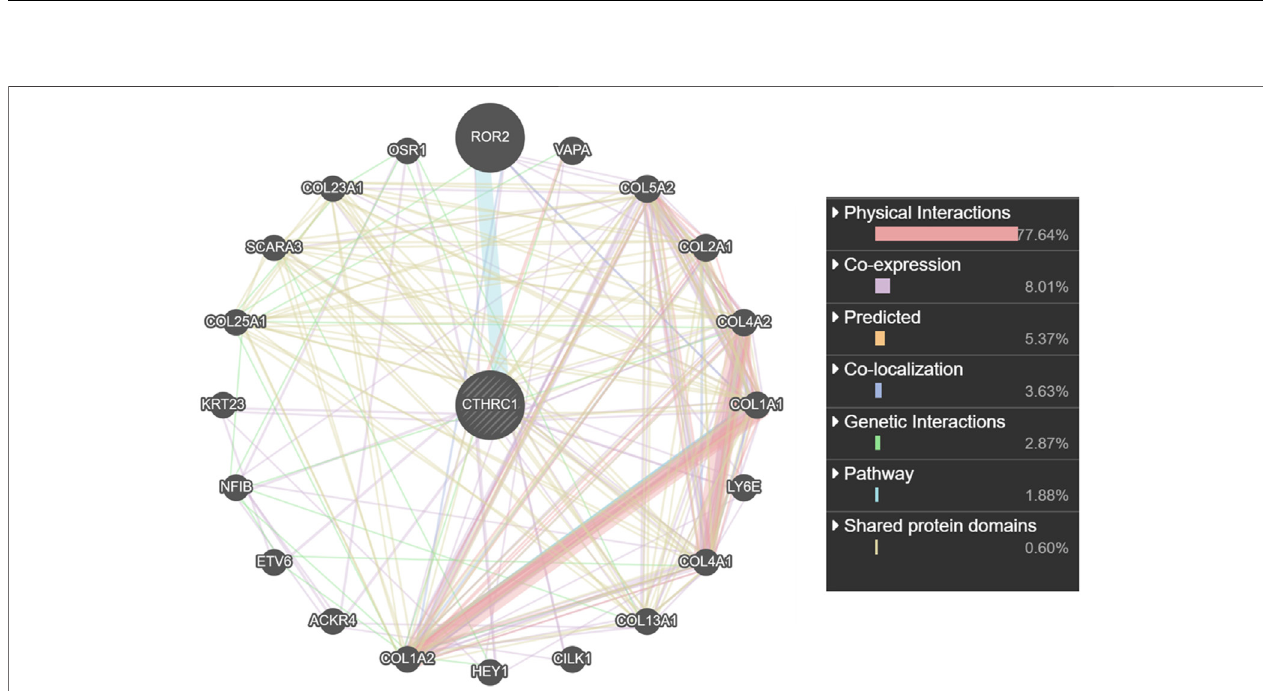
FIGURE 6 | Correlation between CTHRC1 expression and immune cell in fi ltration levels in colon adenocarcinoma tissue analysed via TIMER 2.0. (A – G) The correlation between CTHRC1 expression and immune cell in fi ltration in COAD patients ( n = 458).